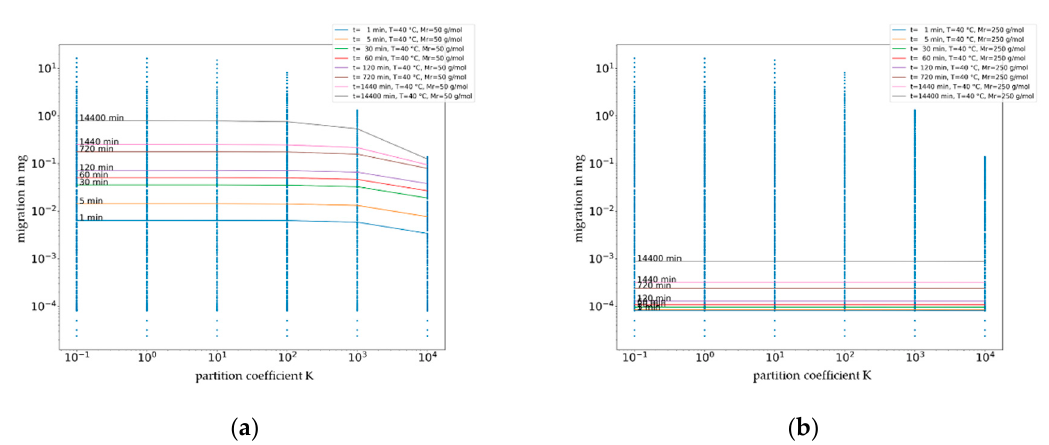
Figure 7. Plot of migration (m) in mg for a generic migrant of molecular weight of 50 g/mol ( a ) and 250 g/mol ( b ) from a PET layer against partition coefficient (K P,F ) at 40 °C in dependence of time.